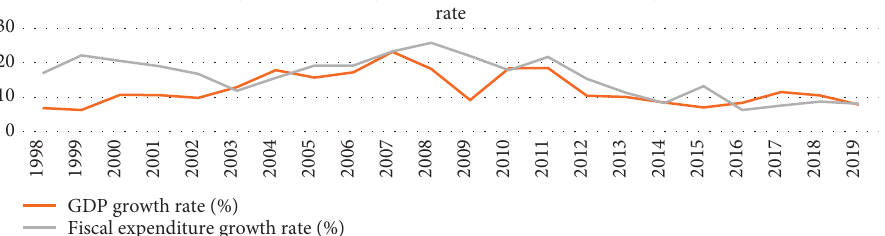
Figure 7: Change trend of China’s GDP growth rate and fiscal expenditure growth rate from 1998 to